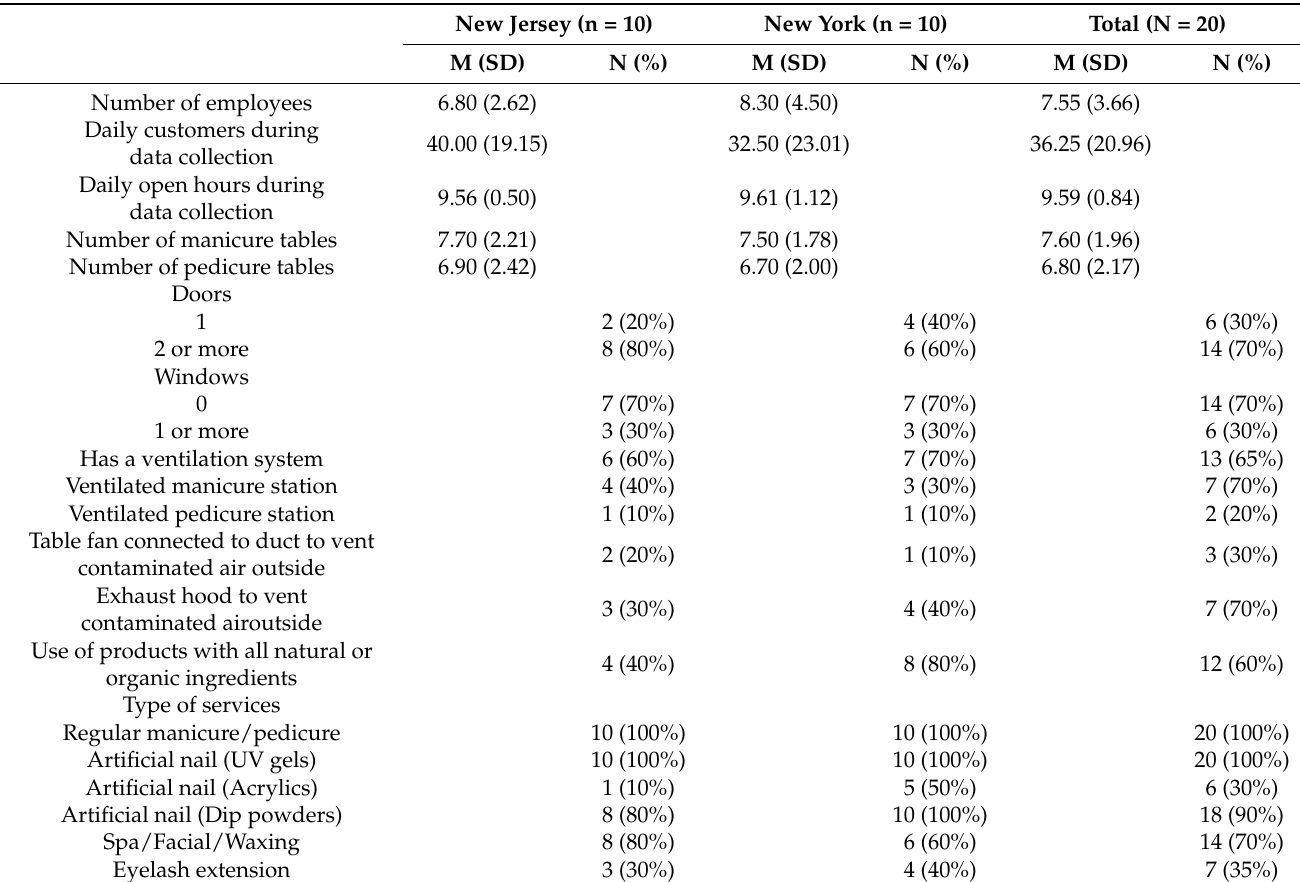
Table 1. Nail salon characteristics and environment (N = 20).